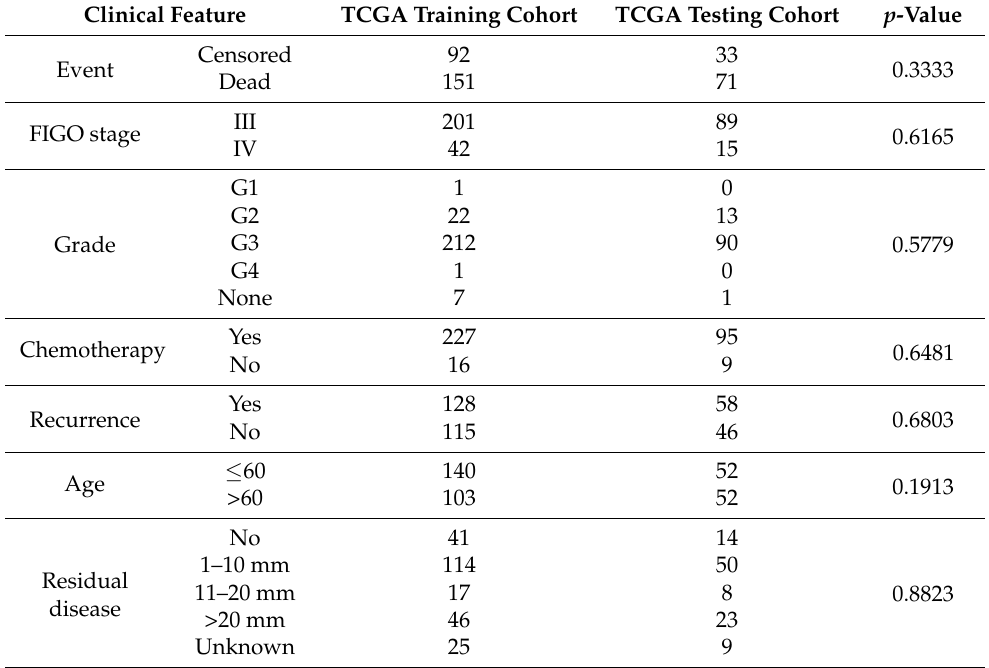
Table 2. Comparison of TCGA training and testing